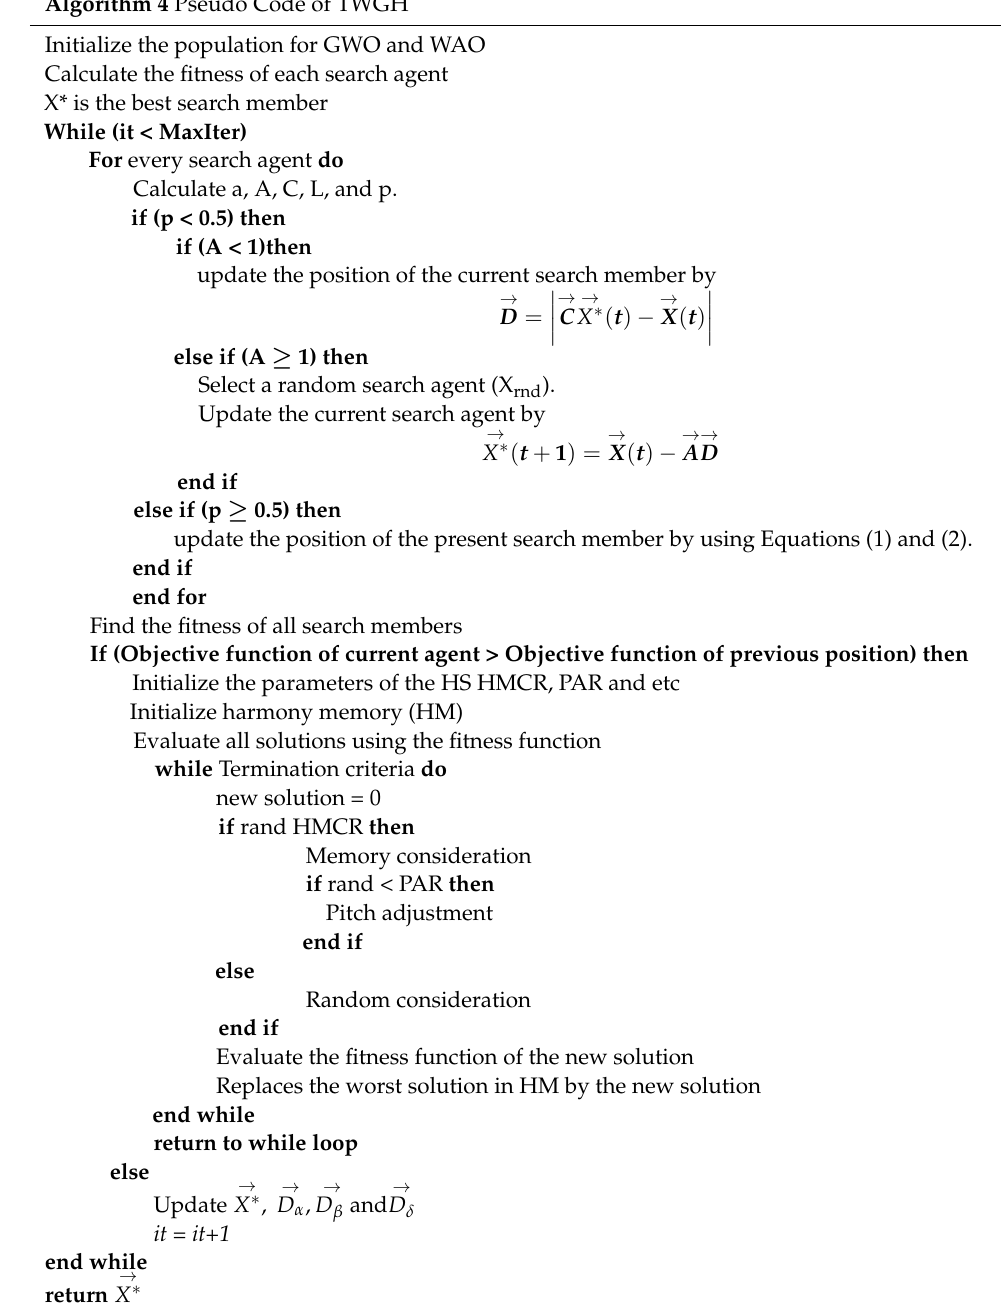
Algorithm 4 Pseudo Code of